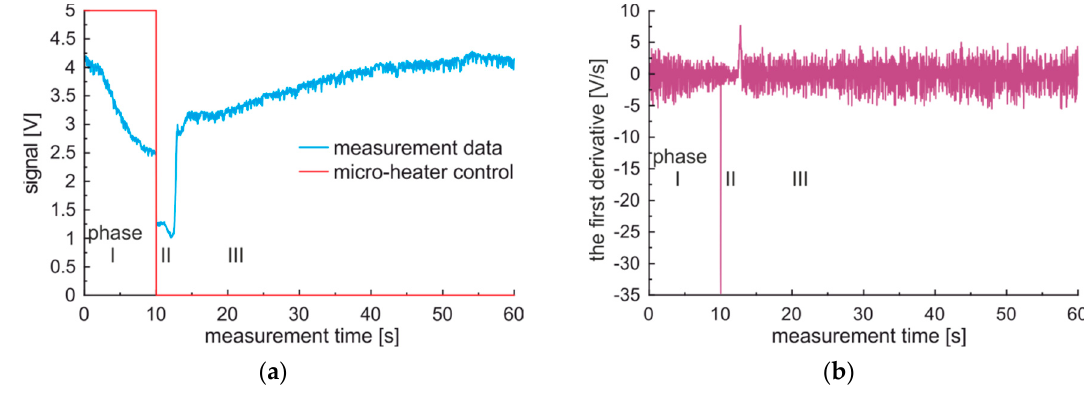
Figure 6. Sample signals of the forced measurement cycle obtained for premium diesel fuel: ( a ) Signal; ( b ) The first derivative.